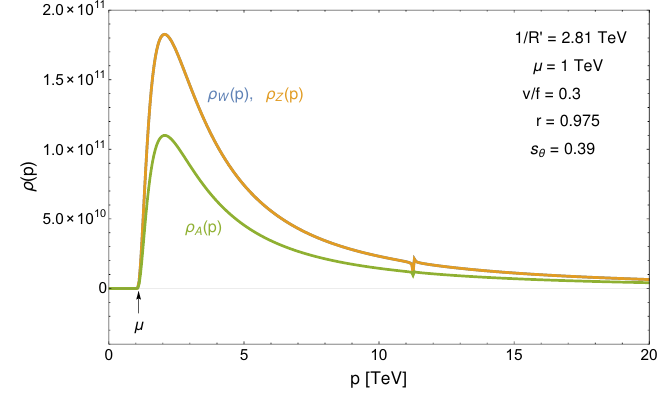
Figure 7 . Gauge spectral density for v=f = 0 : 3 and parameter values from the BP in eq. (5.1).